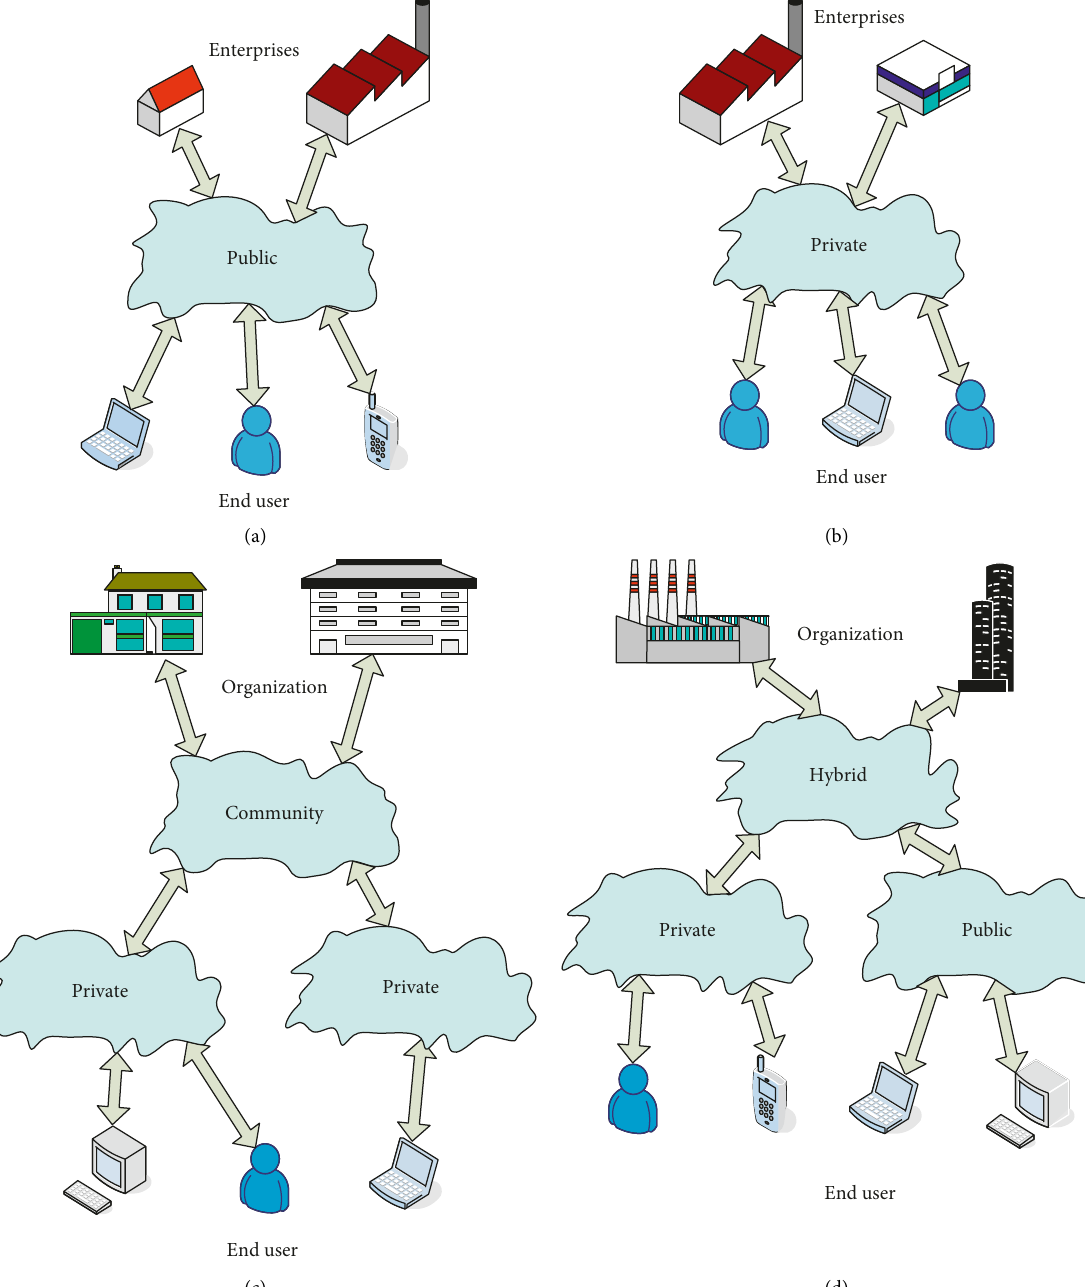
Figure 2: Schematic diagram of four service modes and structures of cloud computing deployment. (a) Public cloud. (b) Private cloud. (c) Community cloud. (d) Hybrid